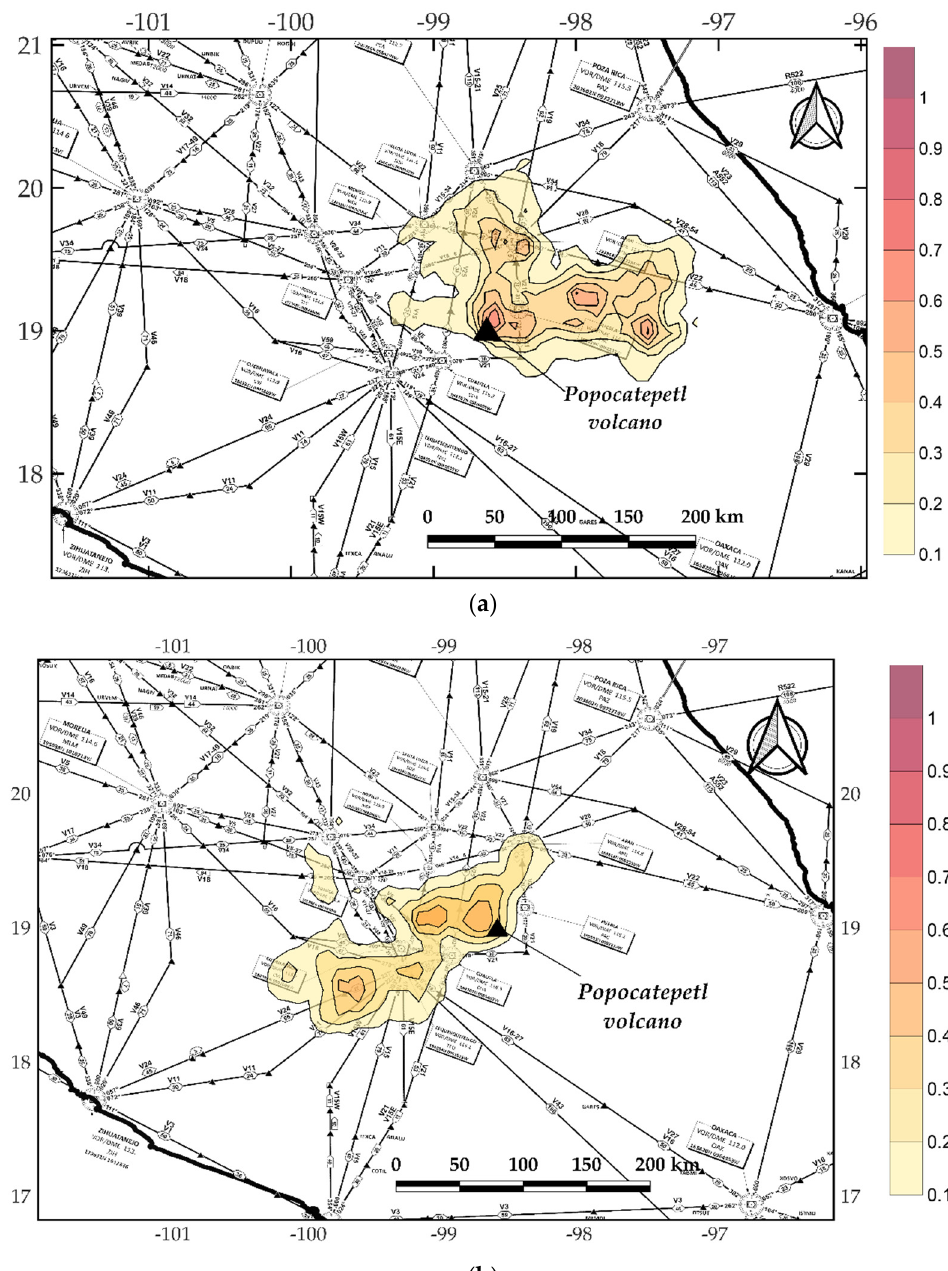
Figure 8. Areas with a high probability of being affected by volcanic ash in the event of an eruption of Popocatepetl volcano: ( a ) in the upper part during the November–May period and ( b ) in the lower part during the July–September period.